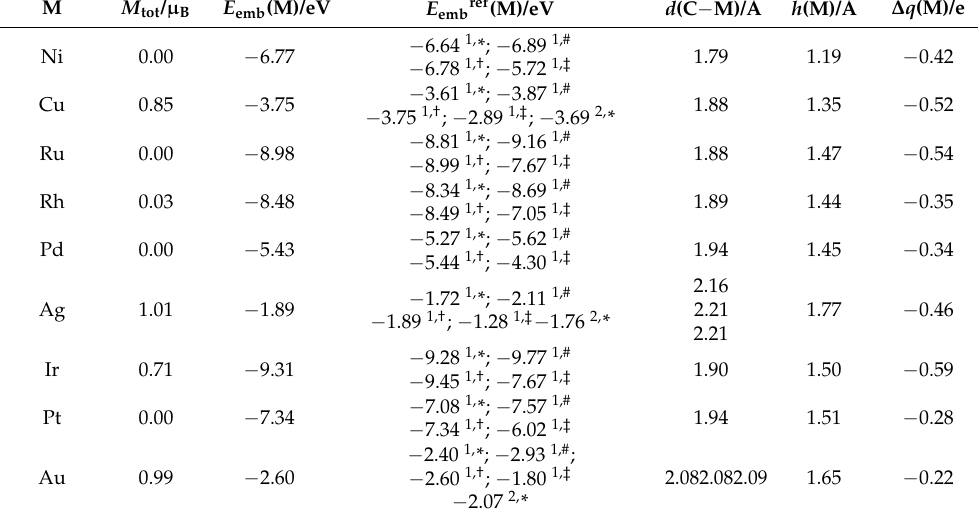
Table 1. Metal (M) incorporation into the vacancy site of vG: total magnetizations ( M tot ), M adsorp- tion energies obtained in this study ( E emb (M)) and the corresponding values found in the literature ( E embref (M)), relaxed M − C distances ( d (C − M)), M protrusion out of the graphene basal plane ( h (M)) and change of Bader charge of M upon adsorption. If all C − M distances are equal, only one value is given. M